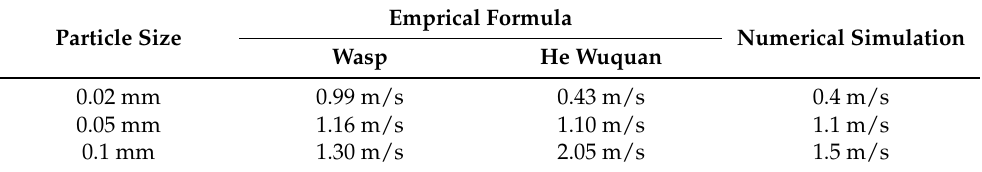
Figure 17. Sand volume concentration changes with flow time (V-inclined pipe L = 80 m d = 0.1 mm). Table 4. Comparison between empirical formula and numerical simulation under different parti- cle